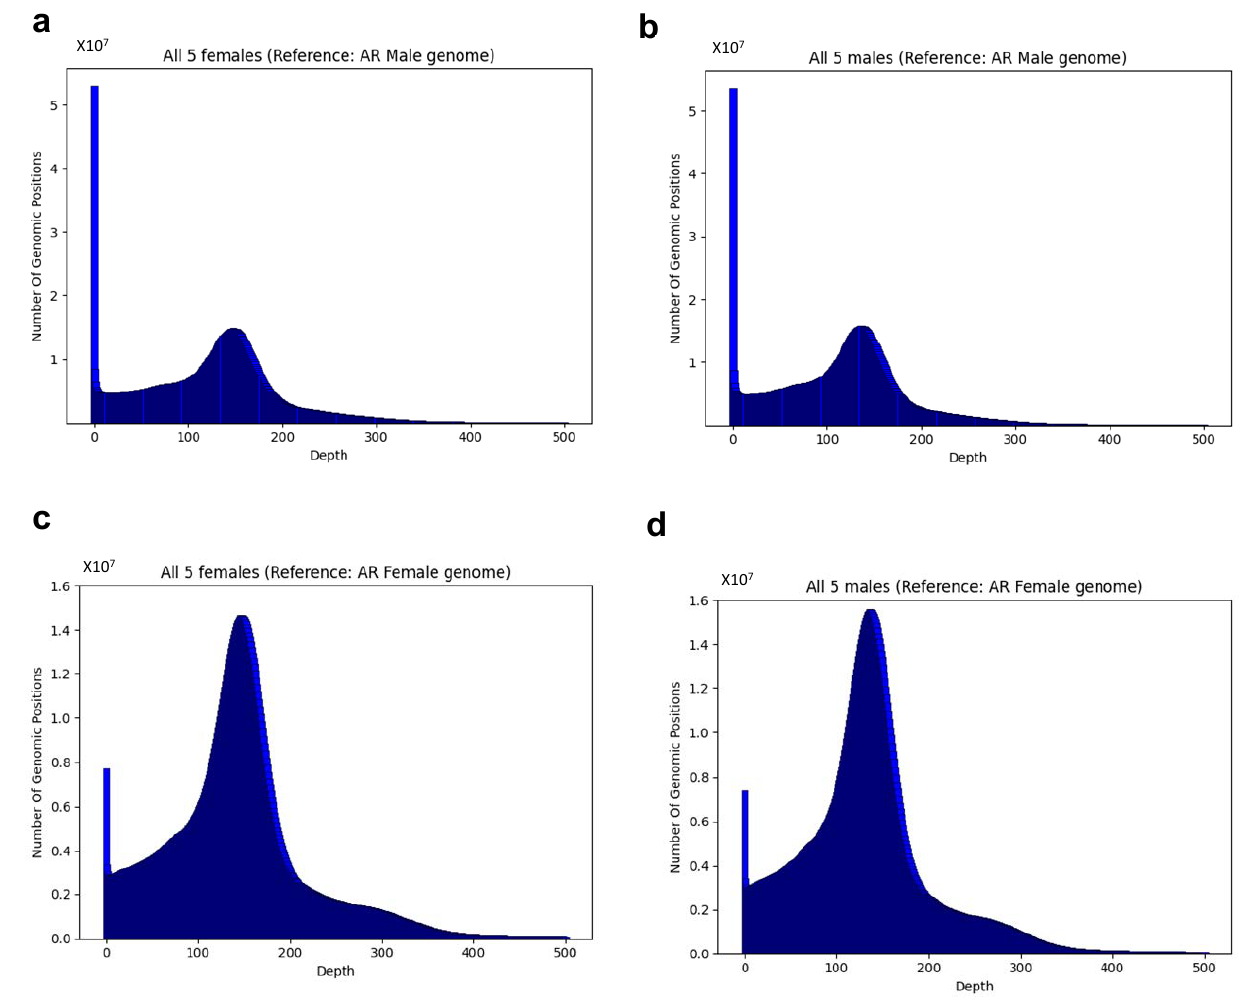
Figure 2. ( a – d ) Distribution of sequencing depth over all genome positions when AG reads are aligned to the AR male or female reference genome: ( a ) female AG reads aligned to male AR reference; ( b ) male AG reads aligned to male AR reference; ( c ) female AG reads aligned to female AR reference; ( d ) male AG reads aligned to female AR reference. Distributions for individual samples and for all samples combined can be found in Figure